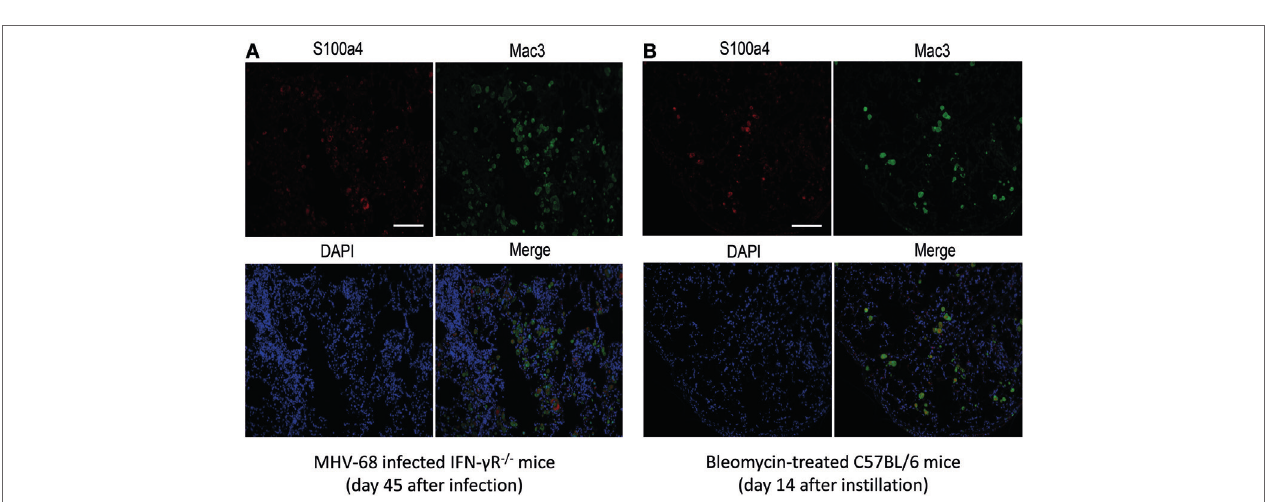
FigUre 2 | Co-localization of S100a4 with Mac3 + macrophages in tissue sections from fibrotic mice. (a) MHV-68-infected IFN- γ R − / − mice at 45 days after infection. (B) Bleomycin-treated C57BL/6 mice at 14 days after instillation. Green fluorescence: Mac3 antigen; red fluorescence: S100a4 antigen; blue fluorescence: diamidino-2-phenylindole-stained nuclei. In the merged image, yellow fluorescence indicates co-localization of S100a4 antigen and alveolar macrophages. All photomicrographs were taken at 200 × magnification. Scale bar 50